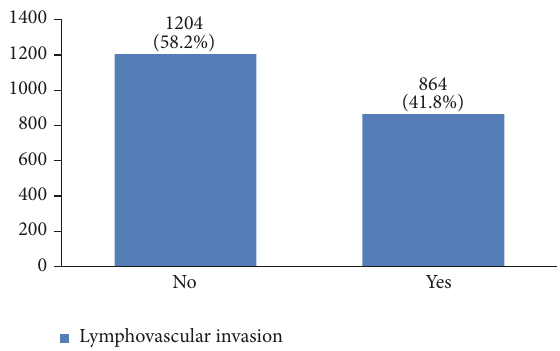
Figure 25: The percentage of lymphovascular invasion in the studied